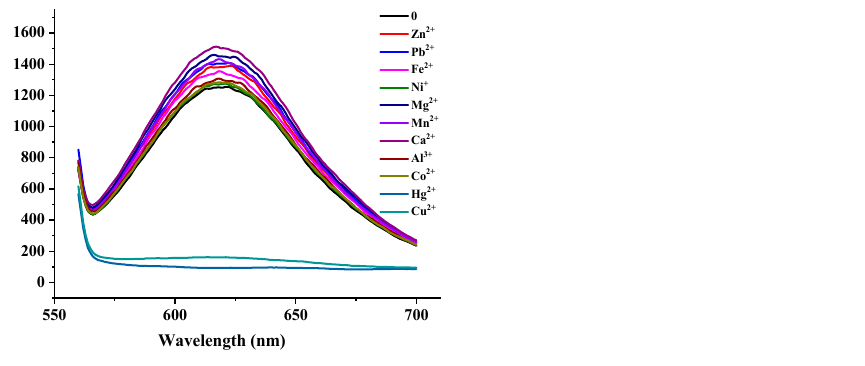
Figure 9. Fluorescence spectra of DNA2-Ag NCs in the presence of different metal ions.